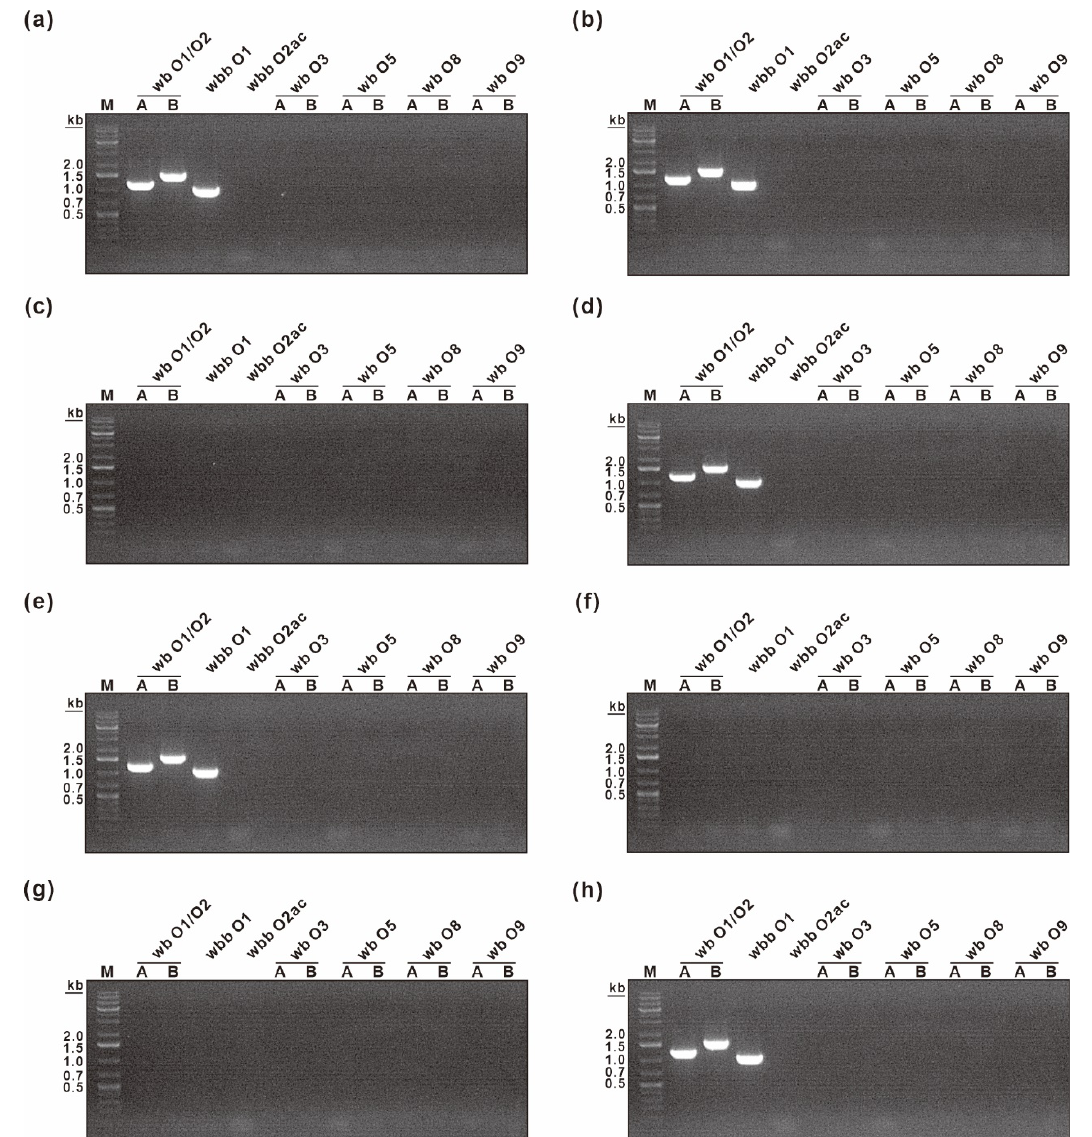
Figure 6. Genotyping of O antigen in a panel of clinical K. pneumoniae isolates by PCR. Agarose gel images showing the PCR amplification of the primers using the genomic DNA of K. pneumoniae as the template were presented. The primer pair name was indicated on top of each lane. The band sizes of the DNA ladder are shown on the left. ( a ) K. pneumoniae KCTC 2208, ( b ) K. pneumoniae KBN 12P00150, ( c ) K. pneumoniae KBN 12P00173, ( d ) K. pneumoniae KBN 12P00237, ( e ) K. pneumoniae KBN 12P02404, ( f ) K. pneumoniae NCCP 15782 ( g ) K. pneumoniae NCCP 16124, ( h ) K. pneumoniae NCCP 16128.